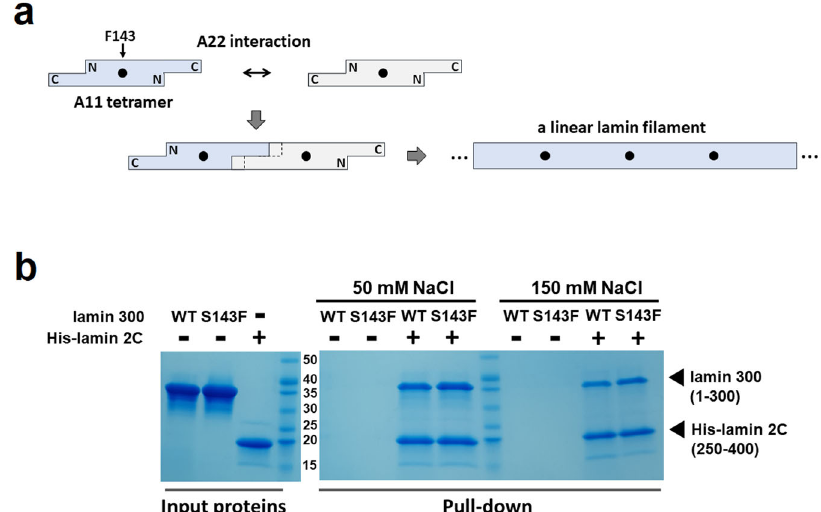
Fig. 3 Effects of the S143F mutation on the A11 and A22 interactions. a A schematic drawing representing linear lamin fi lament formation by the A11 and A22 interactions. The diagram with two wings represents the A11 tetramers of the full-length lamin, where the black dots indicate Phe143 in the S143F mutant lamin A/C. The successive longitudinal overlap between the tetramers by the A22 interactions forms a long linear fi lament, resulting in repetitive Phe143 sites with 40-nm intervals. b SDS-polyacrylamide gel showing the direct binding between lamin 300 and lamin 2 C fragment. The amounts of the protein samples were measured by SDS – PAGE (input proteins). The binding between the lamin 300 fragment (WT and S143F) and the hexaHis-tagged lamin fragment (His-lamin 2 C fragment; residues 250 – 400) was analyzed by pull-down experiments using Ni-NTA resin. The tagless lamin 300 fragments were incubated on the empty resin ( − ) or hexaHis-tagged protein-bound resin. Then, the resins were pre-equilibrated and washed with 20 mM Tris-HCl (pH 8.0) buffer containing 20 mM imidazole and 50 mM or 150 mM NaCl for pull-down, followed by SDS – PAGE analysis. COMMUNICATIONS BIOLOGY| (2022) 5:267